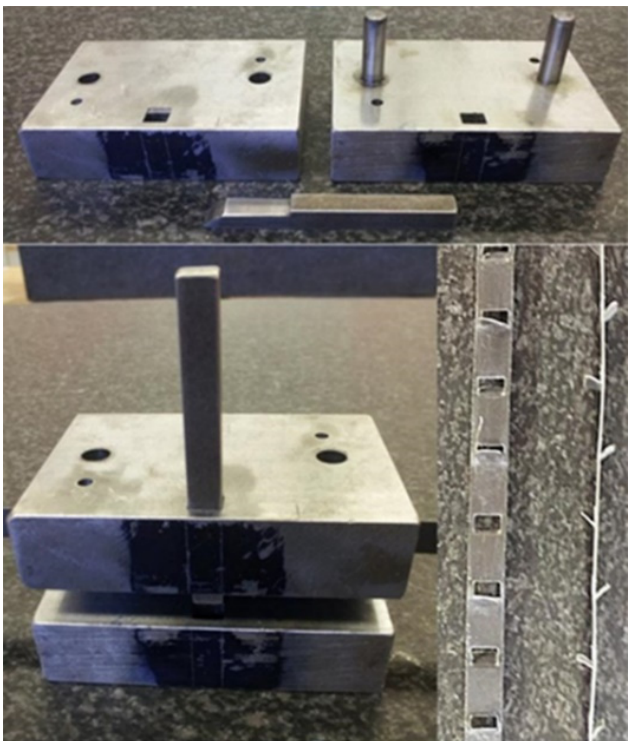
Figure 25. Flow obstructing inserts used by Amaral et. al. with the punching tool for making these. Reprint with permission [99]; Copyright 2021, Elsevier.